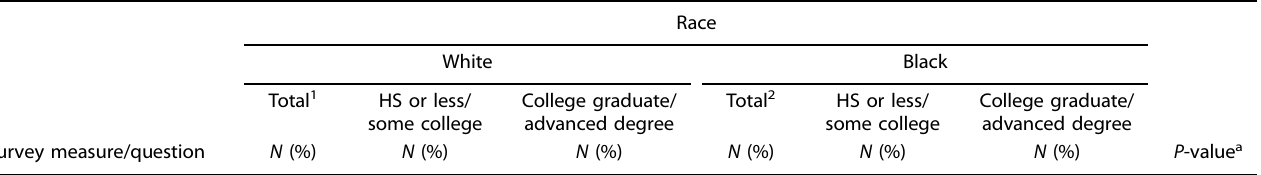
Table 2. Patient experience with providers participating in a pharmacogenomics implementation program by self-reported race and educational